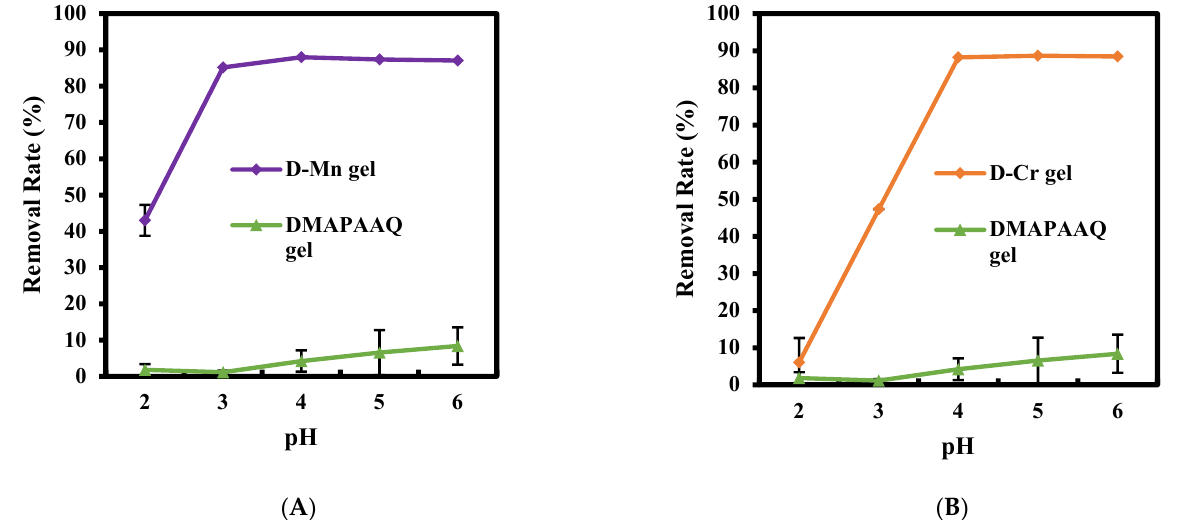
Figure 2. Effect of pH on the As(III) removal rate of the ( A ) D-Mn and ( B ) D-Cr gels.